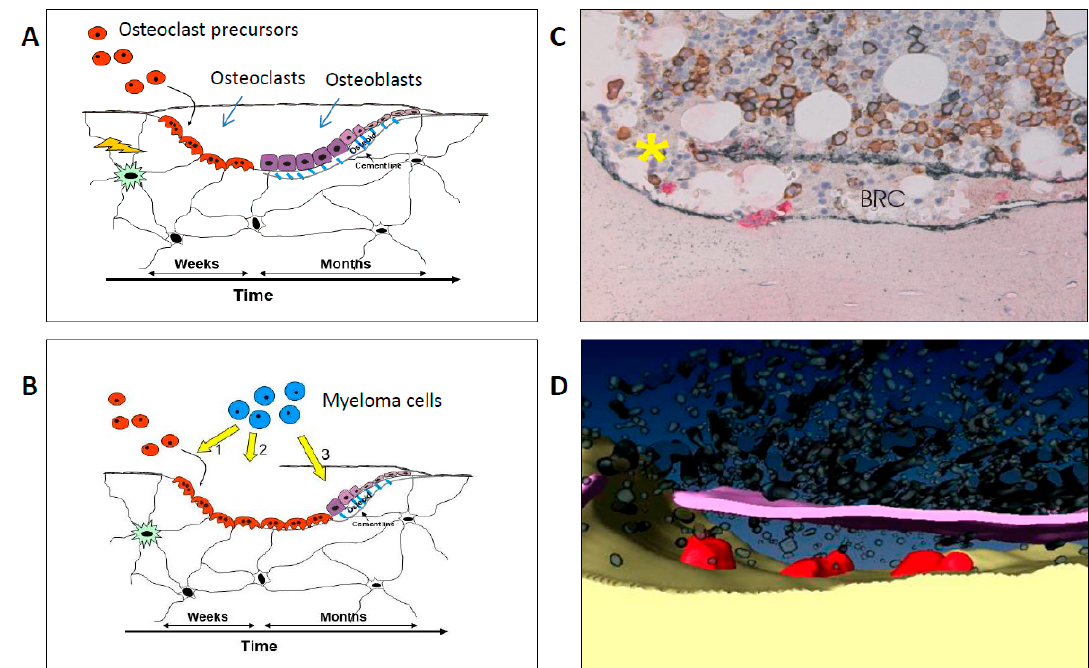
Figure 1. ( A ) Cartoon illustrating the normal bone remodeling taking place in bone remodeling compartments (BRC) that are separated from the bone marrow environment by a thin roofing canopy.